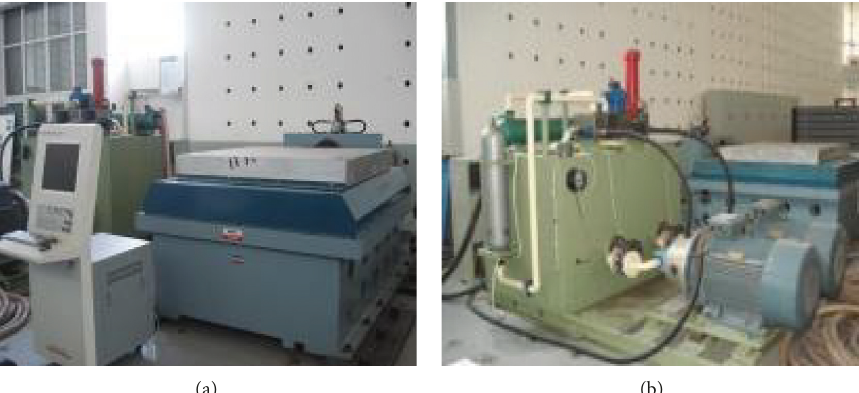
Figure 10: Vibration equipment (reproduced from the study of Huang et al. [20], under the Creative Commons Attribution License/public